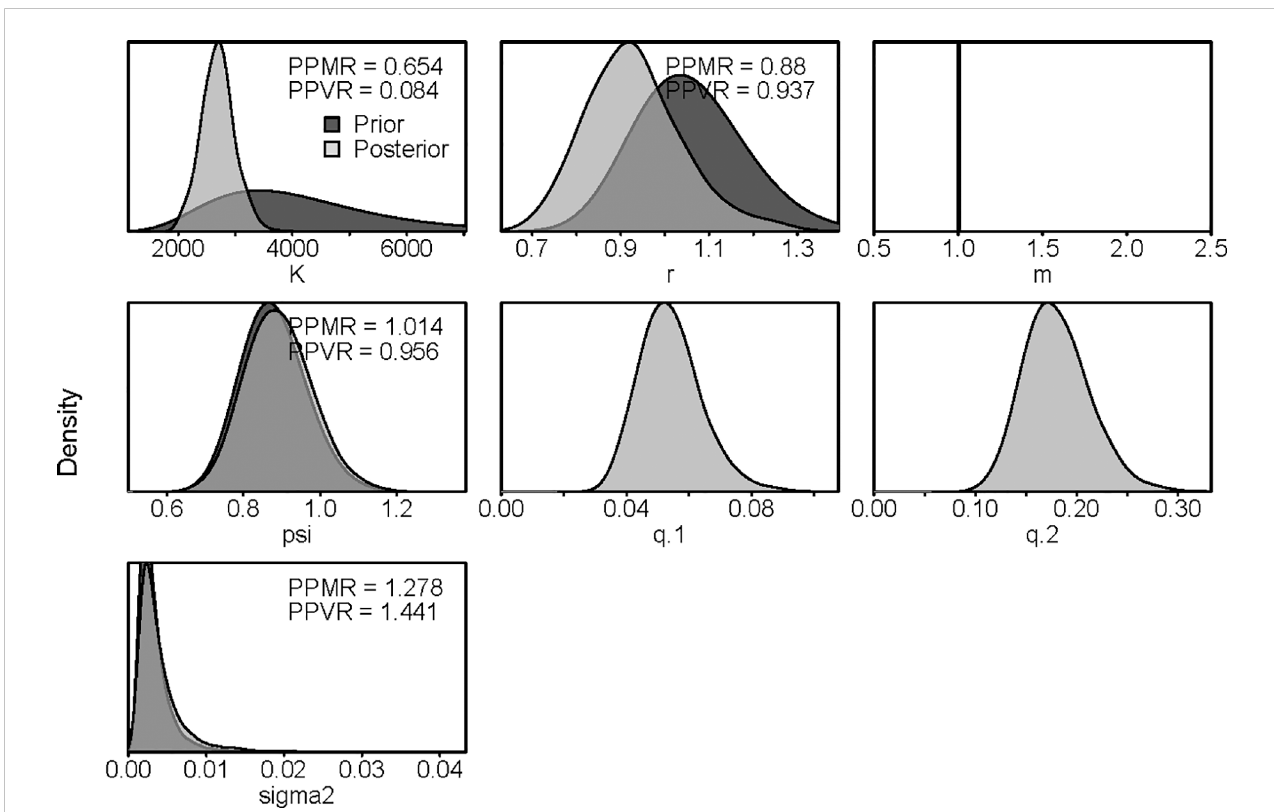
FIGURE 4 The prior and posterior distributions of key JABBA (Fox scenario) model parameters for Japanese anchovy based on the survey biomass index. PPMR: Posterior -Prior Mean Ratio; PPVR: Posterior-Prior Variance